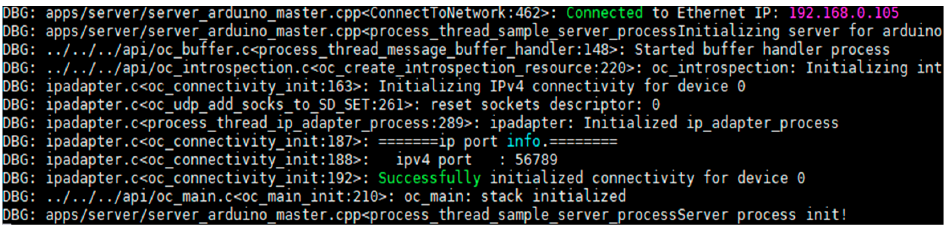
Figure 8. HAN slavers initialization logs.